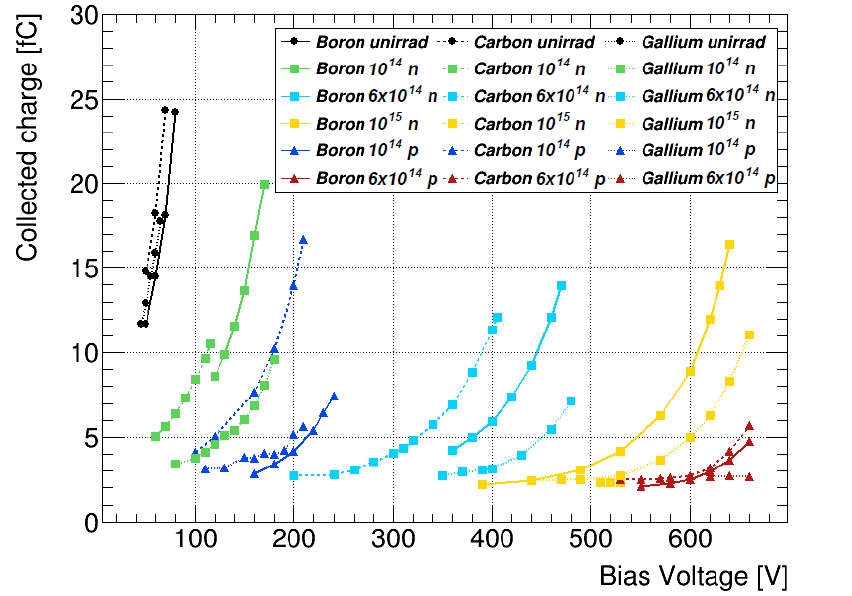
Figure 12. Collected charge as a function of the bias voltage for CNM LGADs irradiated up to a fluence of 10 15 n eq /cm 2 at −